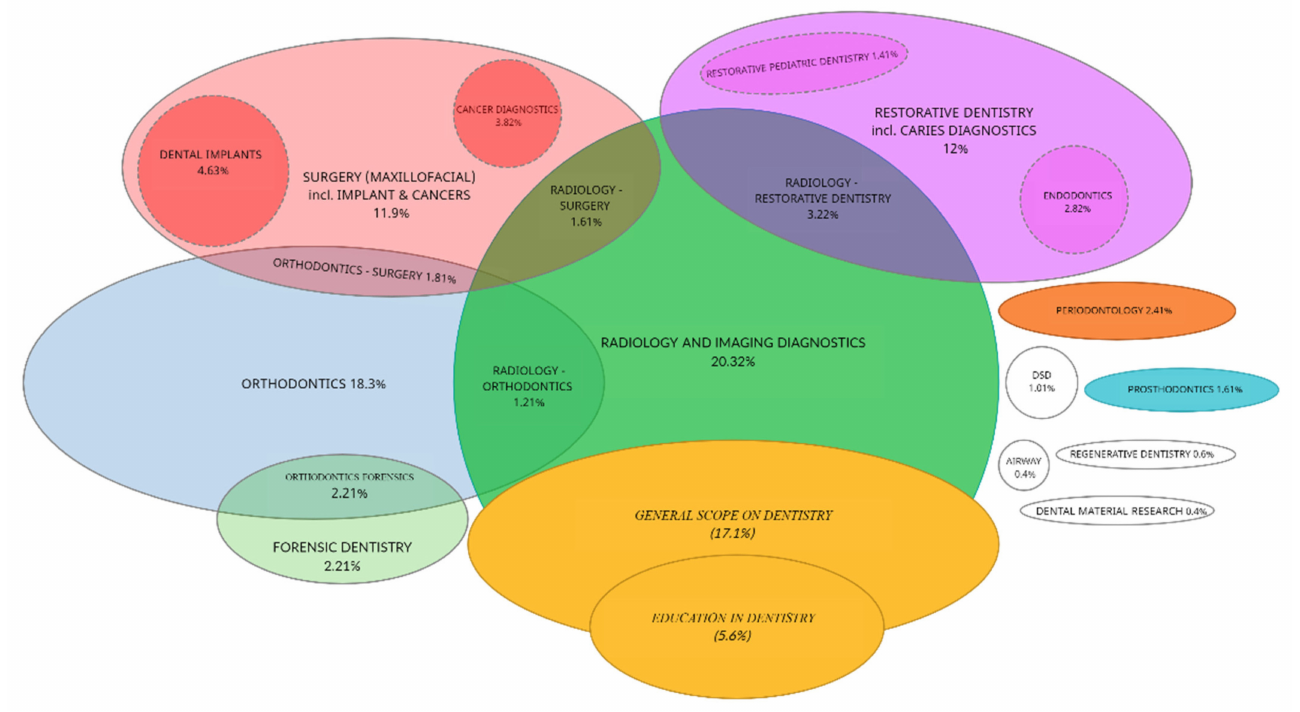
Figure 7. Venn diagram illustrating where dental AI use is currently focused, with relationships among the